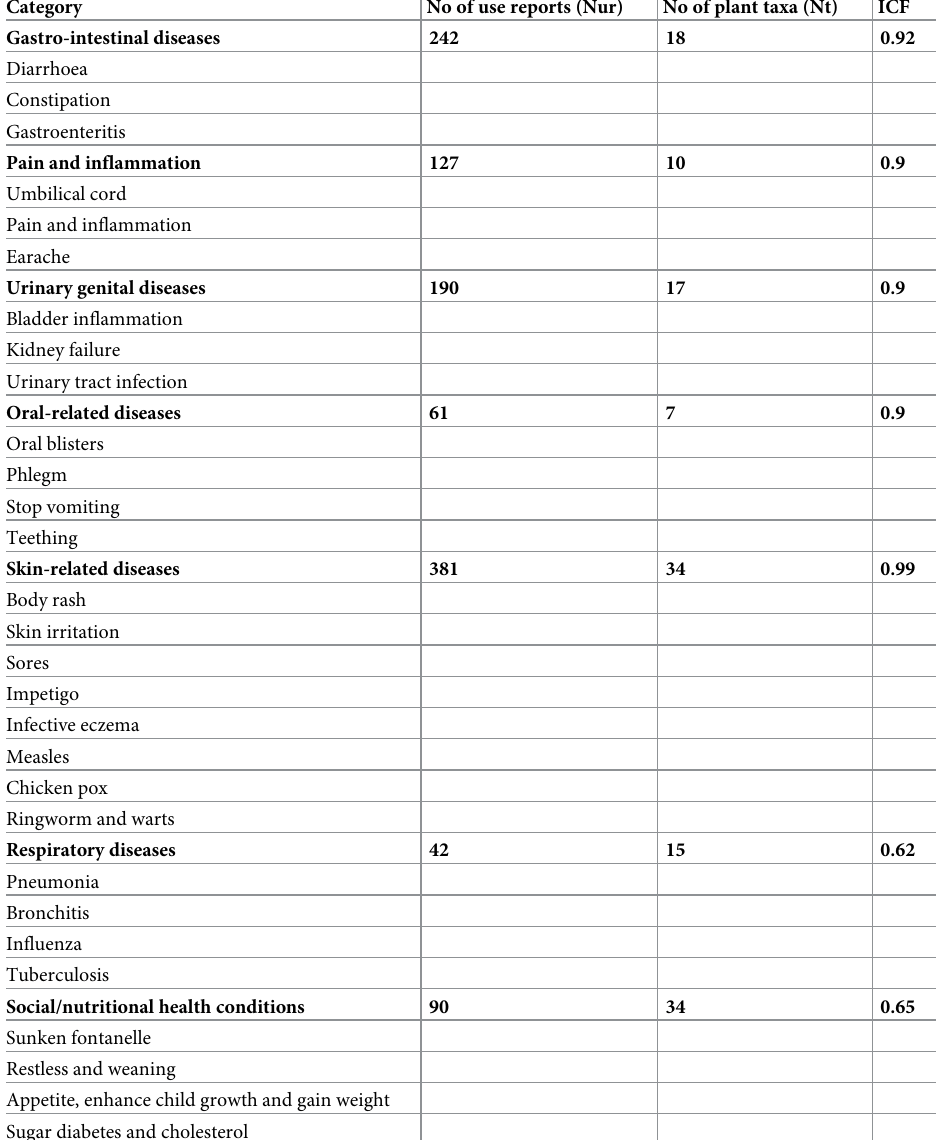
Table 4. Childhood diseases based on categories and informant consensus factor (ICF) in Ngaka Modiri Molema and Bojanala districts of North West Province, South